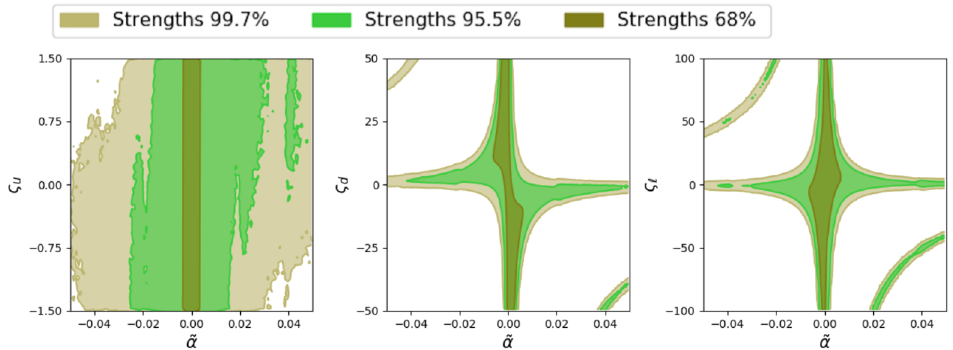
Figure 5. Constraints on the planes ˜ α − ς f from the Higgs signal strengths at a 68% (dark green), 95.5% (light green) and 99.7% (olive green)